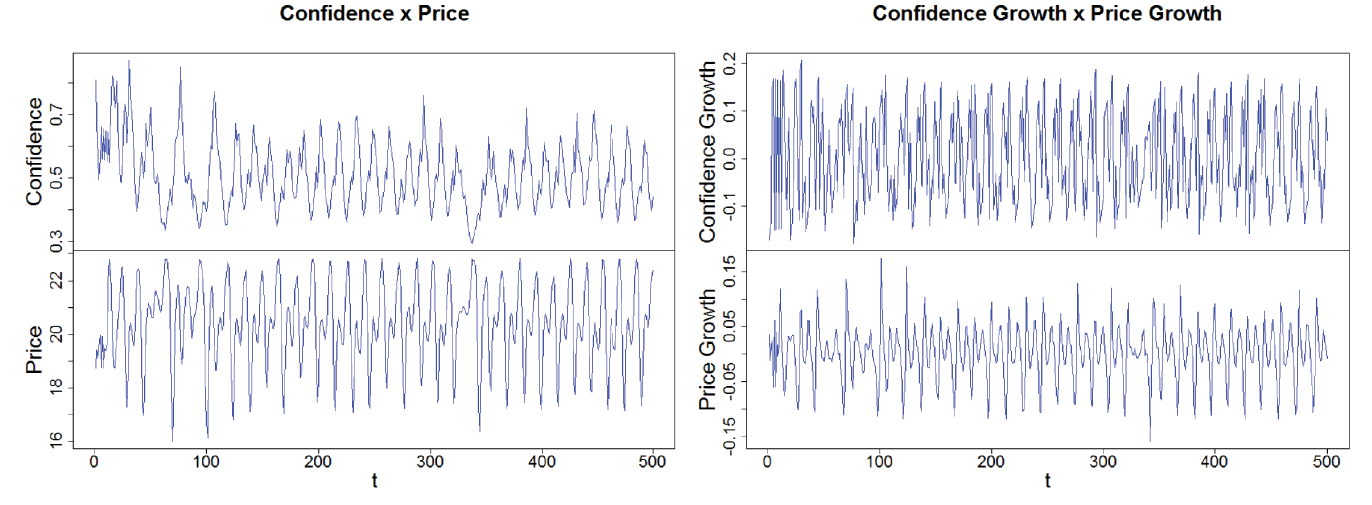
Fig 8. Time series illustrating (on the left) the confidence index and the stock price and (on the right) their respective growth rates. Source: Own